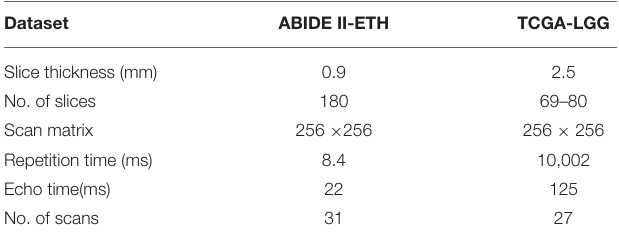
TABLE 1 | Dataset